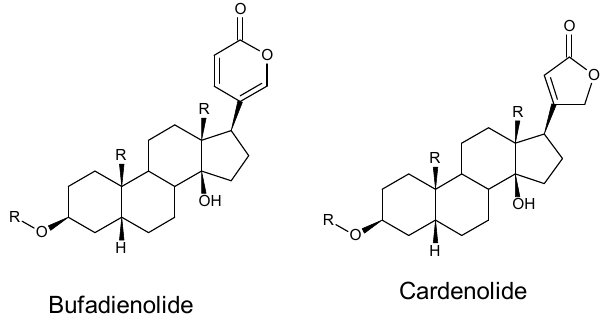
Figure 1. The basic chemical structures of the aglycones of bufadienolides and cardenolides.